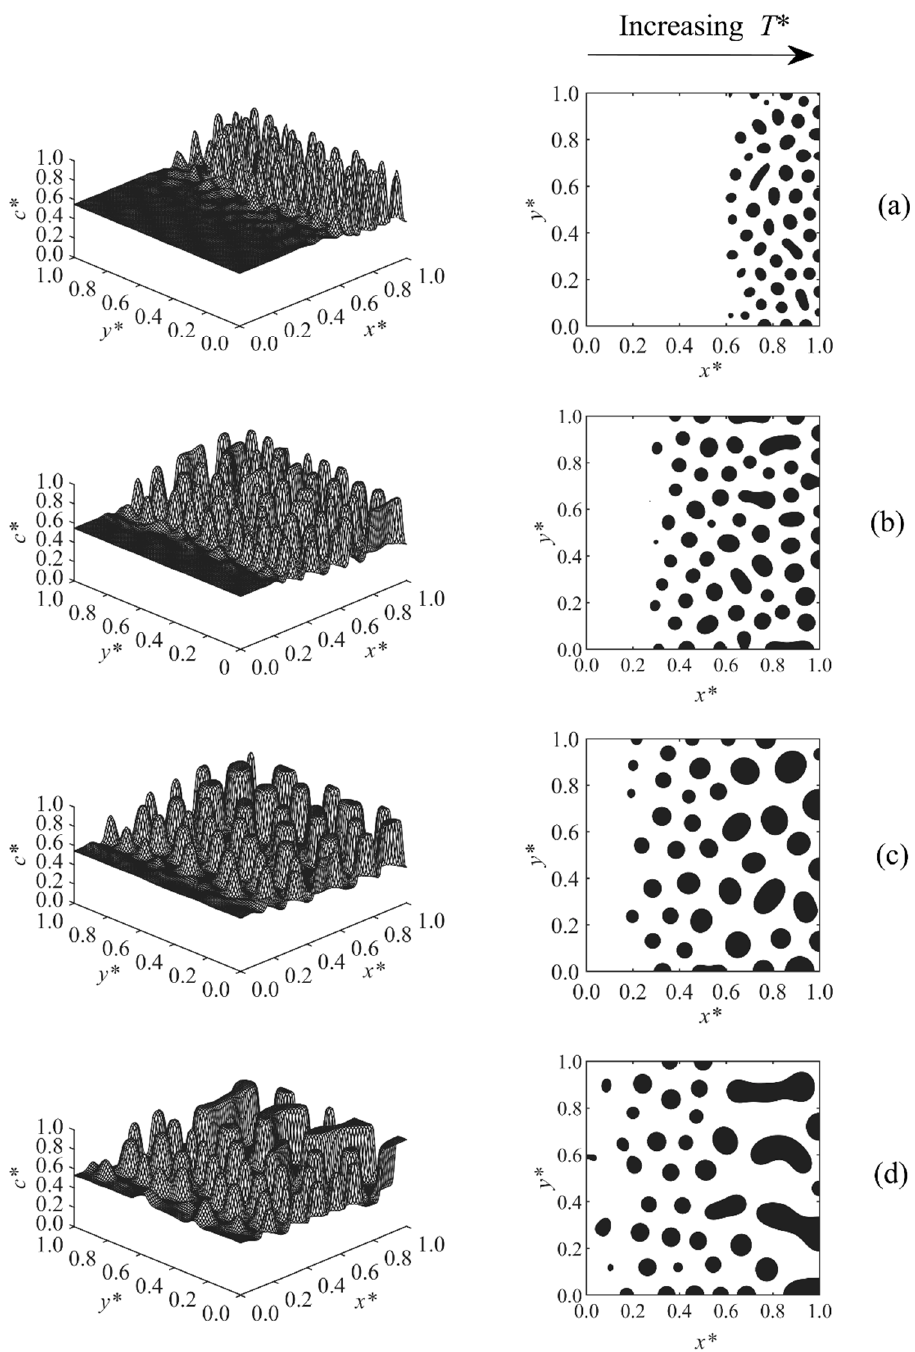
Figure 5. Spatial concentration profiles (first column) and phase-separated patterns (second column) for Case 4 at the following times: ( a ) t ∗ = 4.312 × 10 − 4 , ( b ) t ∗ = 4.32 × 10 − 4 , ( c ) t ∗ = 4.34 × 10 − 4 , and ( d ) t ∗ = 4.37 × 10 − 4 for Case 4 at the following times: ( a ) * t = 4.37 × 10 − 4 .